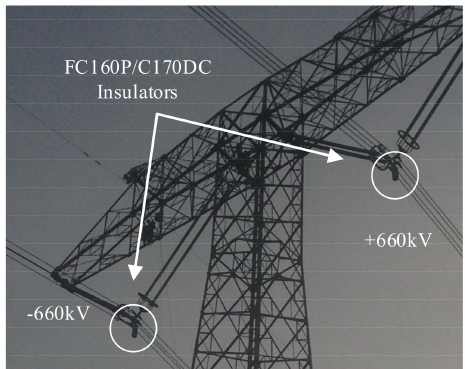
Figure 17. The diagram of the artificial natural pollution test.